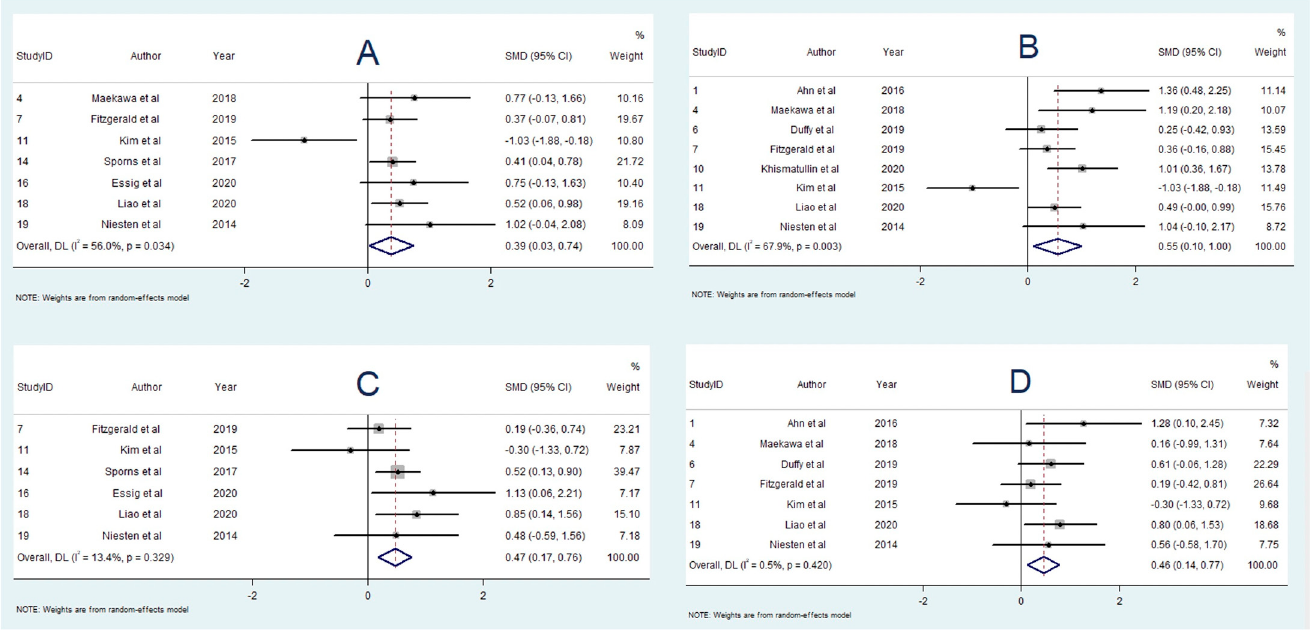
Figure 3. Forest Plots of Meta-analyses on Fibrin Content and Aetiology. ( A ): Cardioembolic vs. Non-cardioembolic stroke. ( B ): Cardioembolic vs. LAA stroke. ( C ): Cryptogenic vs. non-cardioembolic stroke. ( D ): Cryptogenic vs. LAA Stroke. Abbreviations: DL: DerSimonian and Laird method, SMD: Standarized Mean Difference, CI: Confidence Interval, LAA: Large Artery Atherosclerosis.